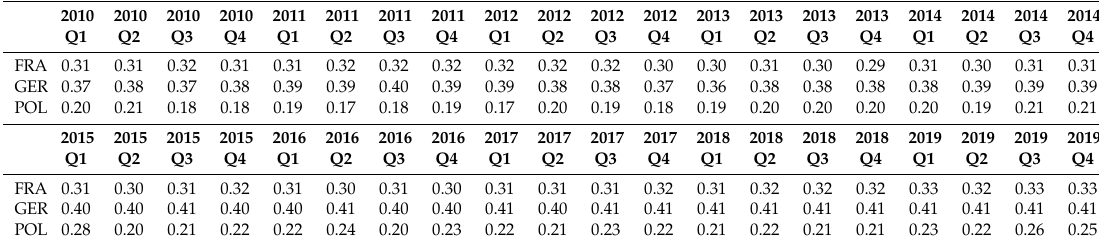
Table 5. Propensity to private savings—indicator SP , own work, source: Eurostat.